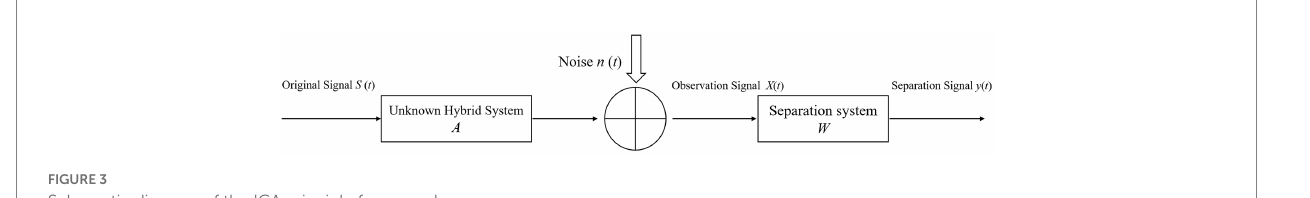
FIGURE 3 Schematic diagram of the ICA principle